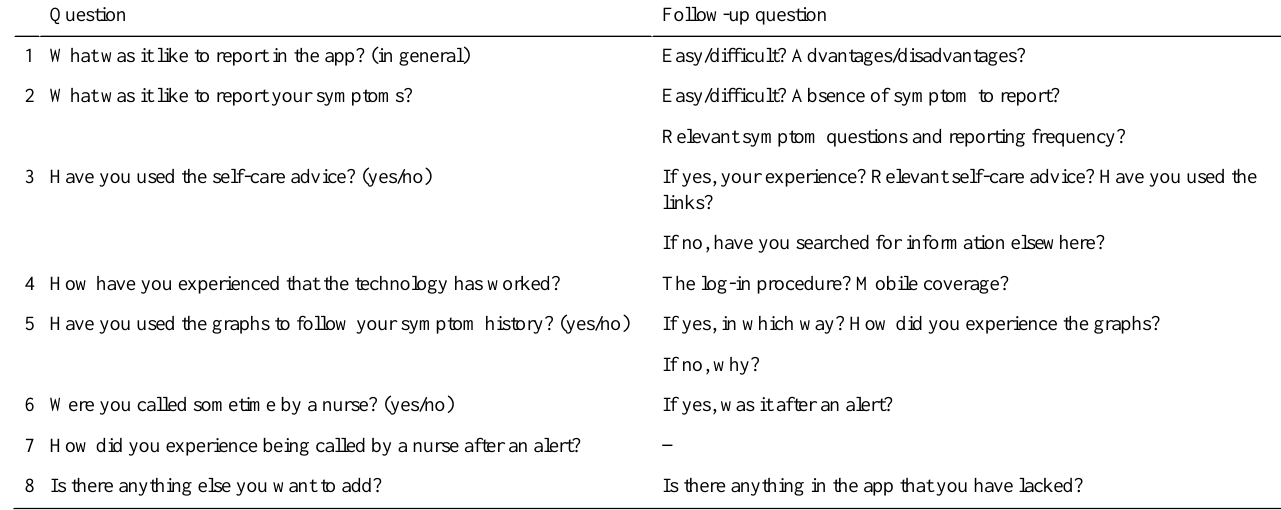
Table 1. Interview guide.